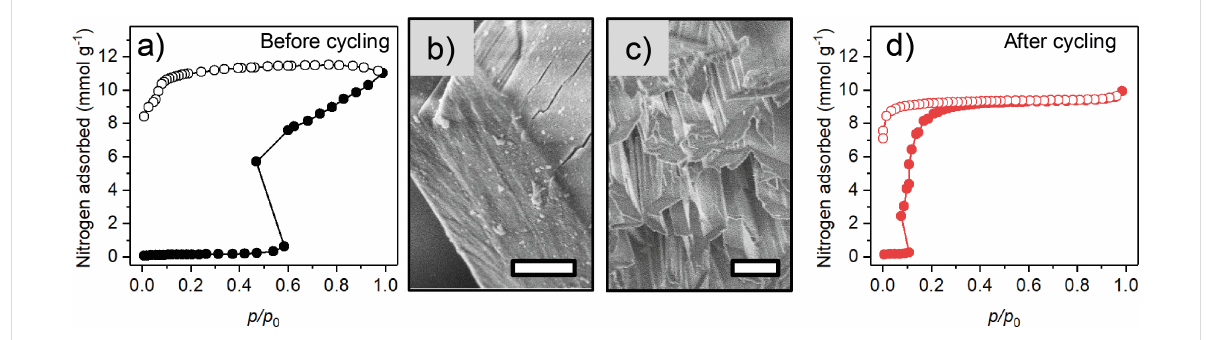
Figure 2: Nitrogen adsorption isotherms at 77 K (a,d) and SEM images (scale bars 1 µm) (b,c) of DUT-98(1) before (a,b) and after (c,d) adsorption experiments with nitrogen, CO 2 , n -butane, and vapors of alcohols and hydrocarbons (for details on the adsorption experiments see [23]). Closed symbols: adsorption, open symbols: